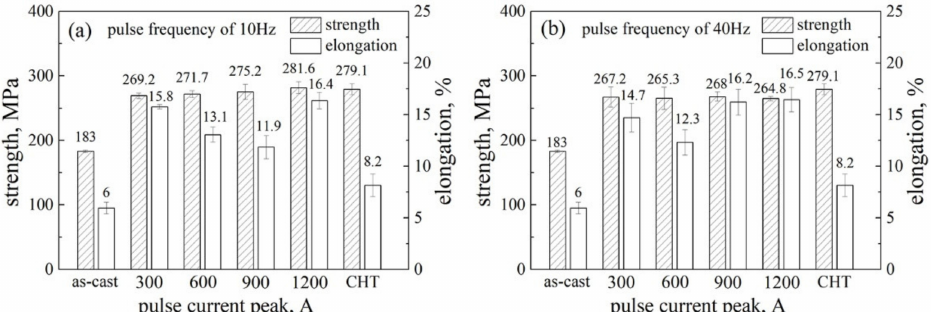
Figure 8. Tensile strength and elongation of the Al-7Si-0.55Mg alloy after aging treatment at di ff erent conditions: ( a ) 10 Hz; ( b ) 40